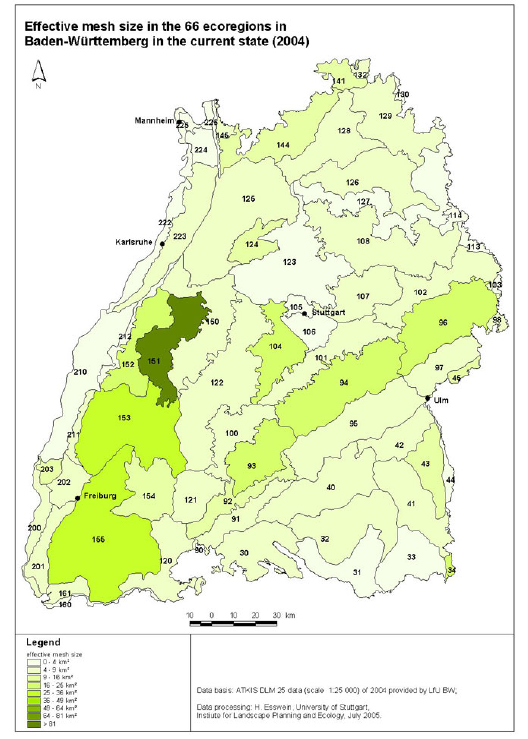
version. File size: 252